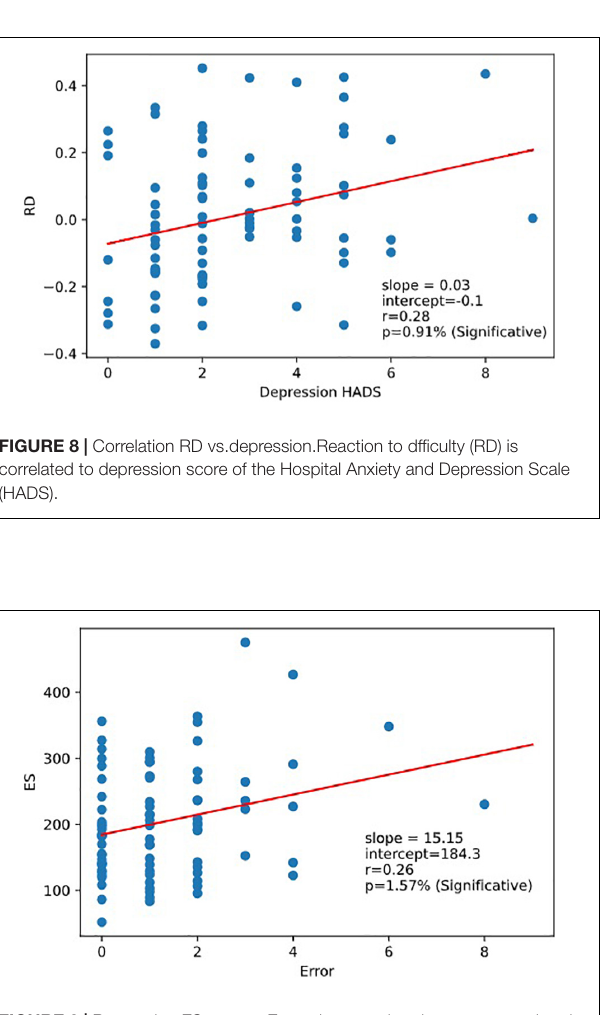
FIGURE 9 | Regression ES vs.error.Executive speed and error are correlated. Linear relation between executive speed and errors.Pearson coefficient of regression (ES, Errors r = 0.264 p =